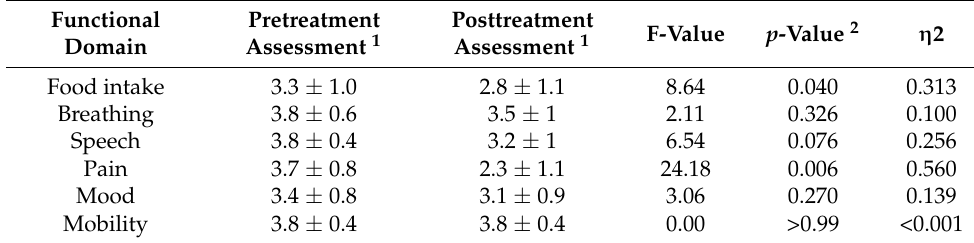
Table 5. Responsiveness values of the HNC-FIT